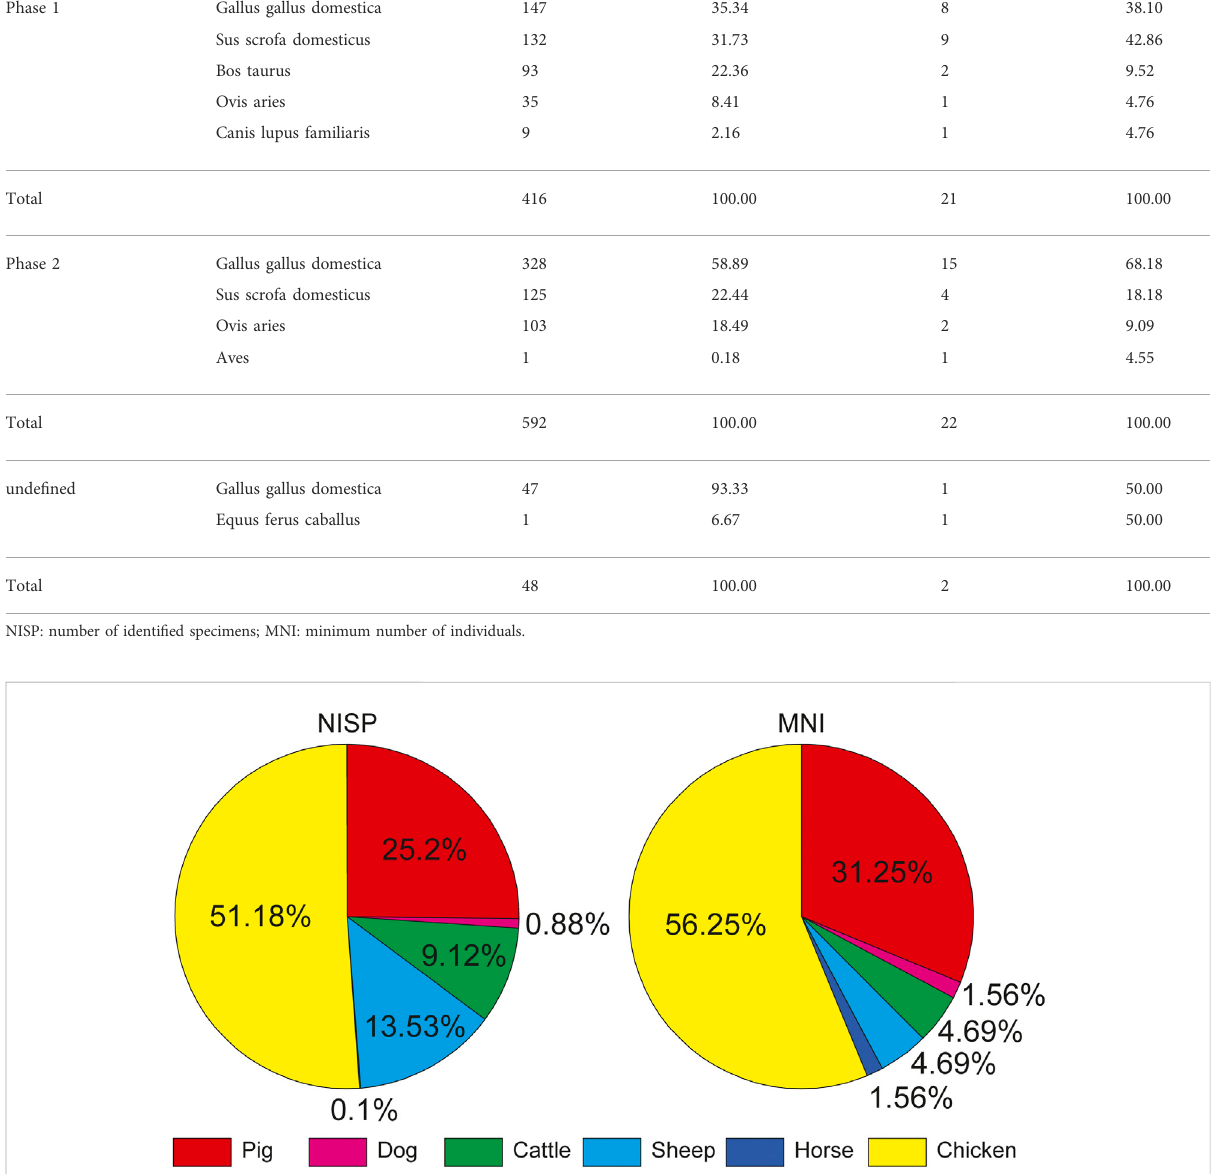
Table 1 and plotted in Figure 2. Based on the characteristics of the cemetery (GPICRA, 2019) and the results of the absolute dating, the animal samples in this study were divided into two periods: 190 – 50 BCE (phase 1, the middle Western Han) and 50 BCE – 200 CE (phase 2, late Western Han to Eastern Han). During phase 1, both the NISP and MNI data for animal bones indicate that chickens account for more than 35 percent of the total